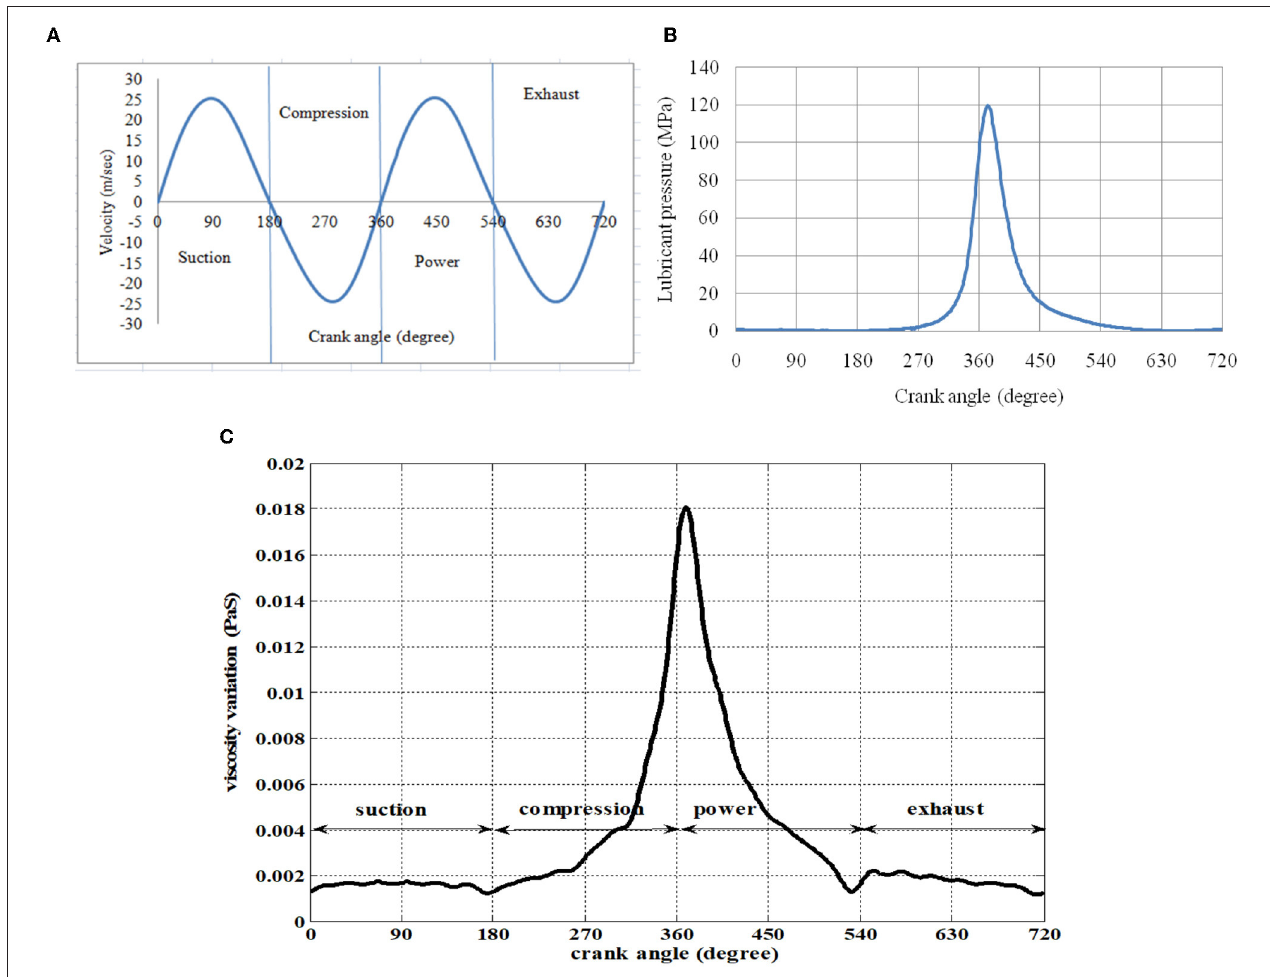
FIGURE 13 | (A) Cyclic variation of piston sliding velocity in an engine cycle. (B) Cyclic variation of lubricant film pressure in an engine cycle. (C) Cyclic variation of viscosity in an engine cycle.